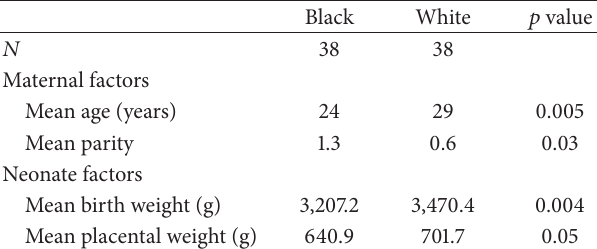
Table 1: Maternal and neonate factors by race, males in the hormones in umbilical cord blood